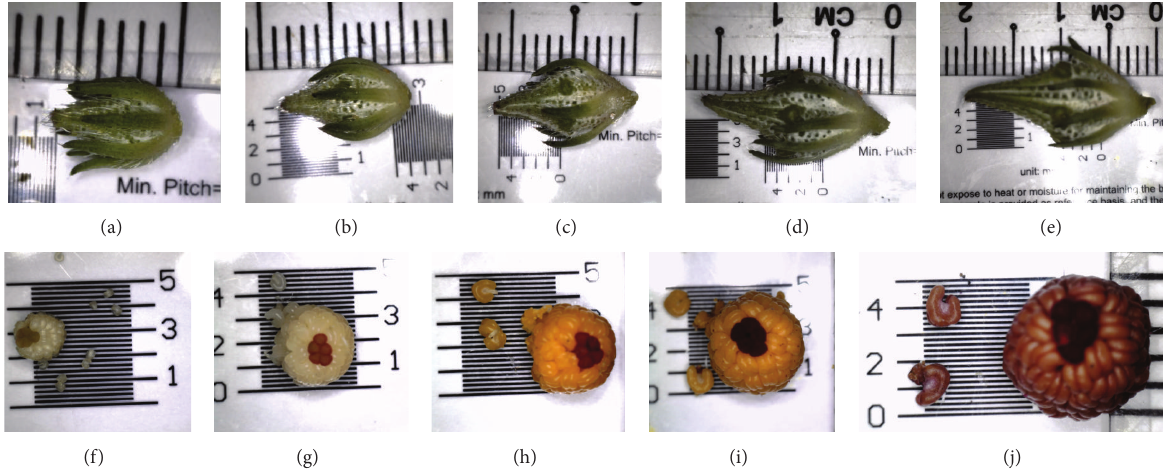
Figure 1: (a)–(e) Different size of flower buds, (f)–(j) anther length and diameter of anther bunch.